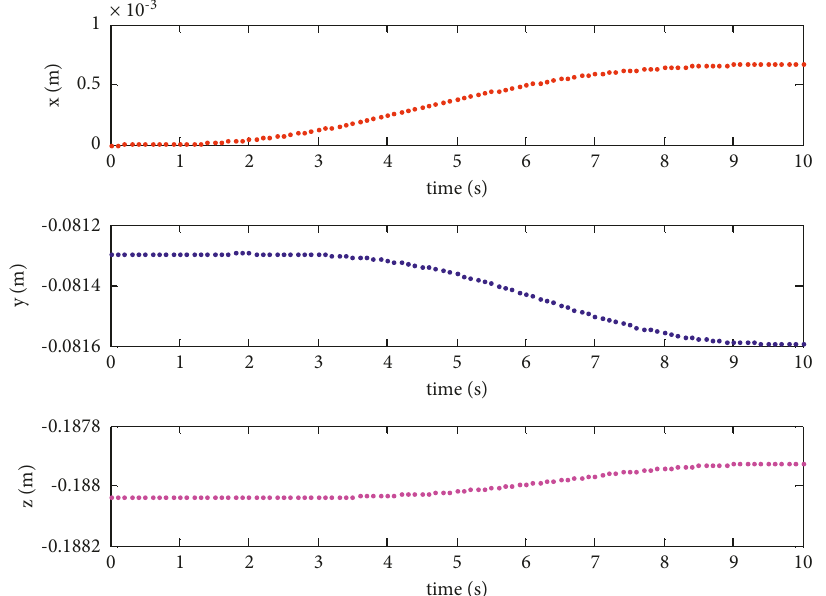
Figure 11: The position of the base obtained by the SAPSO